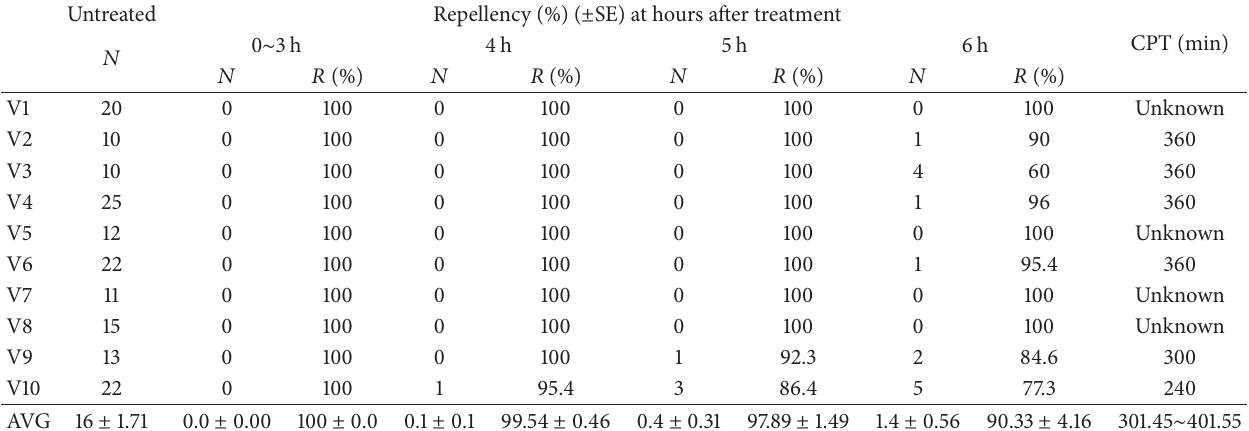
Table 1: Repellency and CPT of 24% DEET against Aedes albopictus in laboratory test. Untreated Repellency (%) ( ± SE) at hours after